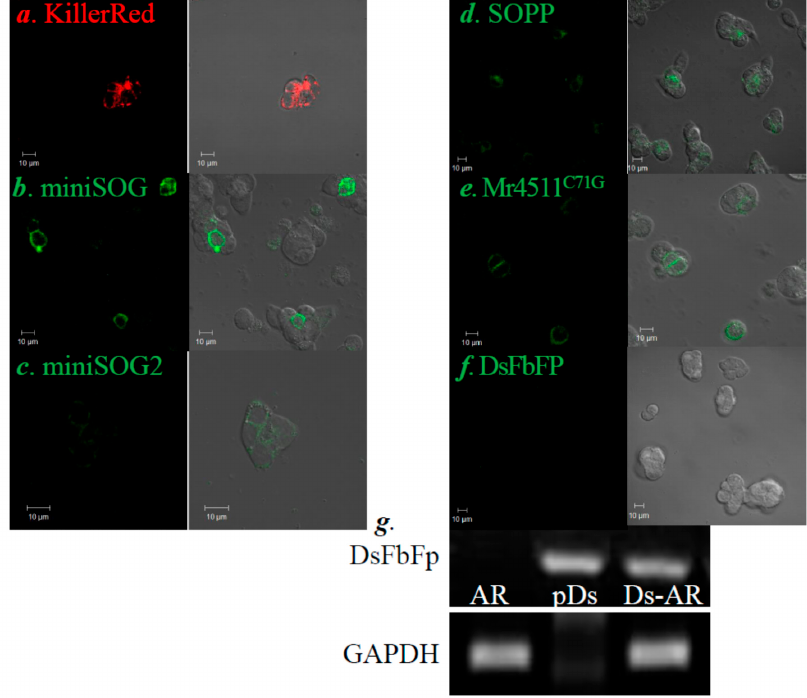
Figure 1. Plasma membrane (PM) expression of genetically encoded protein photosensitizers KillerRed, miniSOG, miniSOG2, SOPP, Mr4511 C71G , and DsFbFP. ( a – f ) AR4-2J cells were